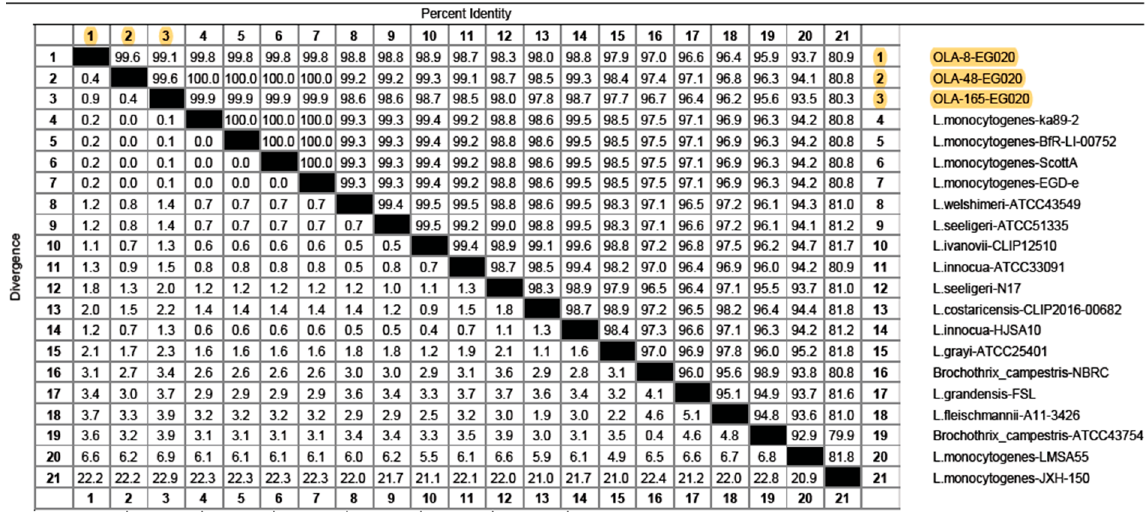
Figure 4. Nucleotide percent identity and divergence between the L. monocytogenes from raw milk, fish fillet and minced meat and related strains retrieved from GenBank. Sequences (highlighted in yellow color) from raw milk (OLA-165-EG020, accession number MW090064), fish fillet (OLA-8-EG020, accession number MW090062) and minced meat (OLA-48-EG020, accession number MW090063) were generated in this study.